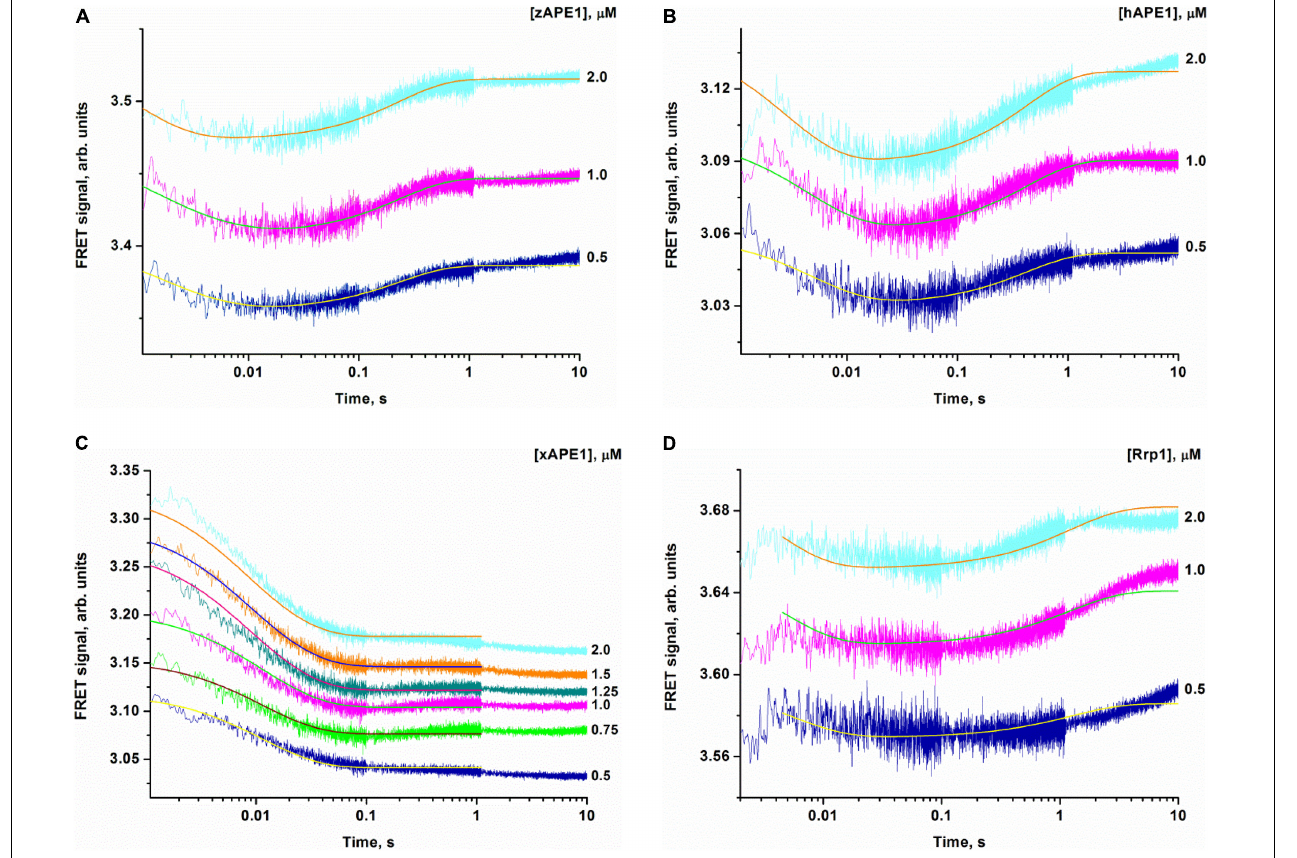
FIGURE 5 | Changes in the FRET signal during the interaction of zAPE1 (A) , hAPE1 (B) , xAPE1 (C) , or Rrp1 (D) with the nondamaged DNA. (DNA) = 1.0 µ M, and concentrations of enzymes are shown on the right in the panel. Traces were fitted by nonlinear least-squares regression